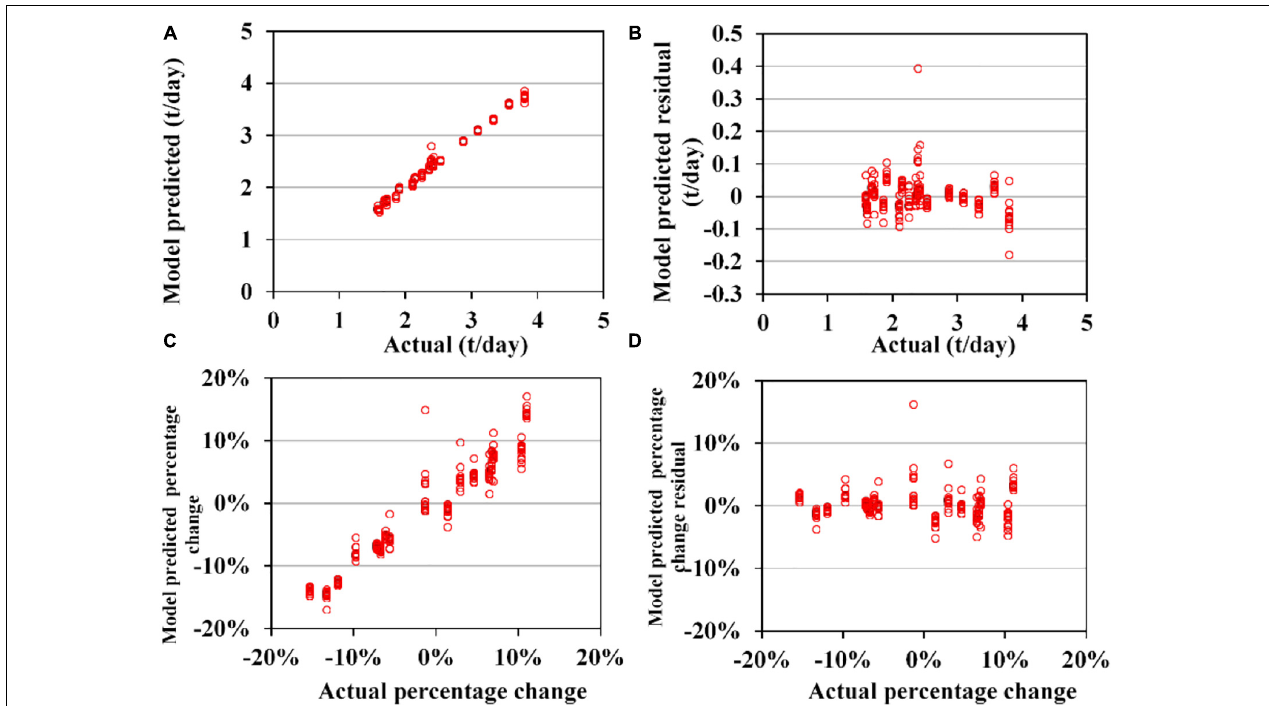
FIGURE 7 | Cross-validation results of 153 sub-models of generalized additive models (GAM) for the interannual abundance trend of Ommastrephes bartramii (TA). (A) Model-predicted and actual TA; (B) model-predicted residual and actual TA; (C) model-predicted and actual TA percentage change compared with the last year (except for 2003 in which it is compared with the year 2004); (D) the model predicted the residual and actual value for TA percentage change compared with the last